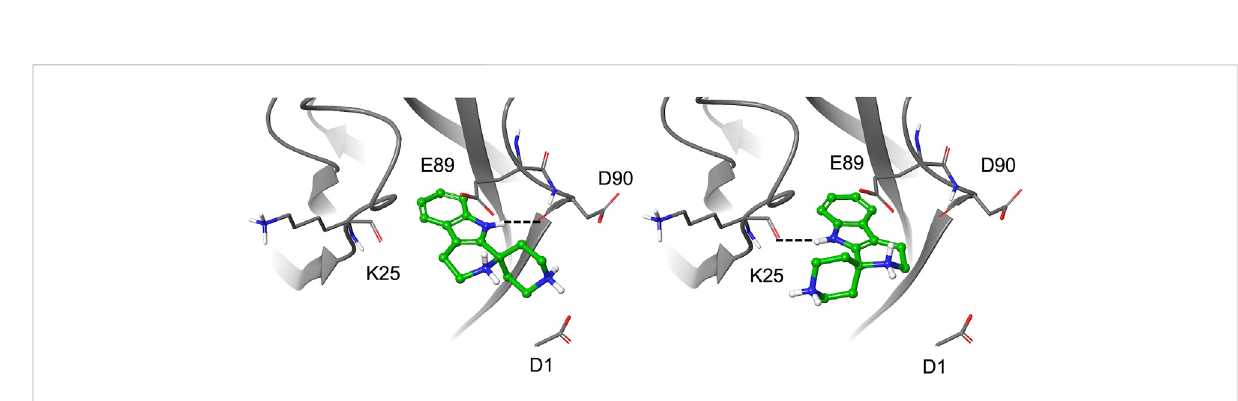
FIGURE 4 Docking pose A (left) and pose B (right) for fragment 1